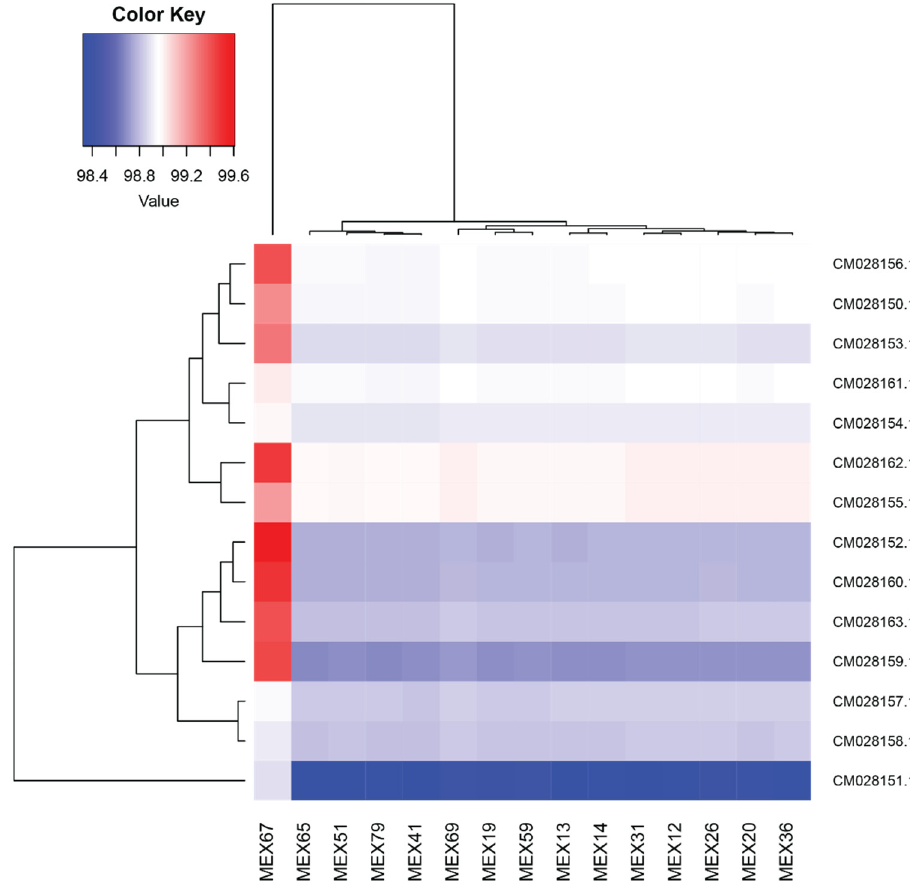
Figure 6. Heat map of chromosomal similarities between Mexican V. planifolia samples and reference ‘Daphna’ genome.